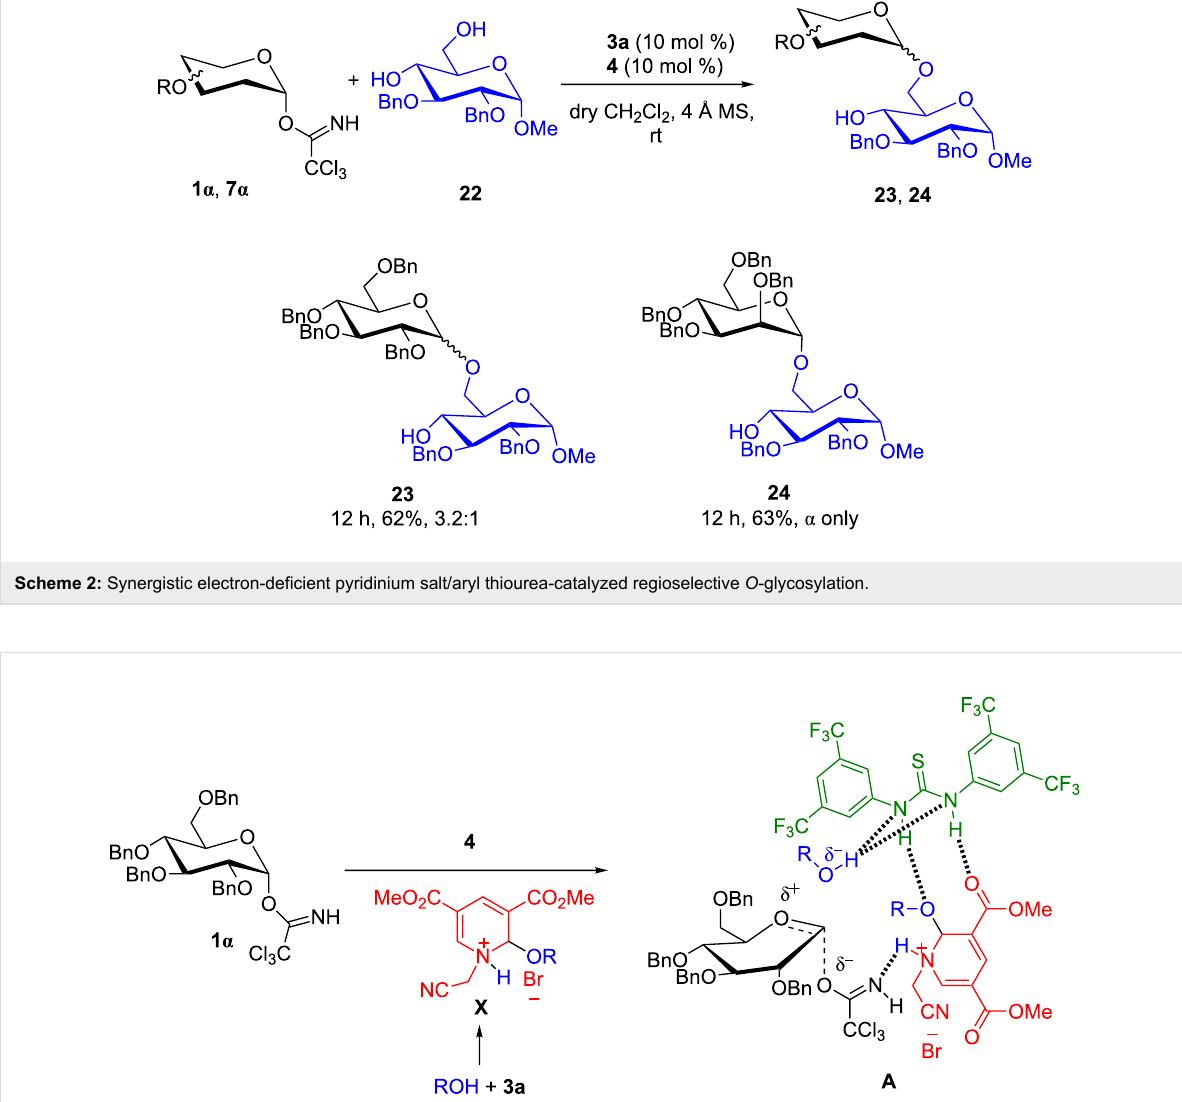
Figure 4: Plausible reaction mechanism.